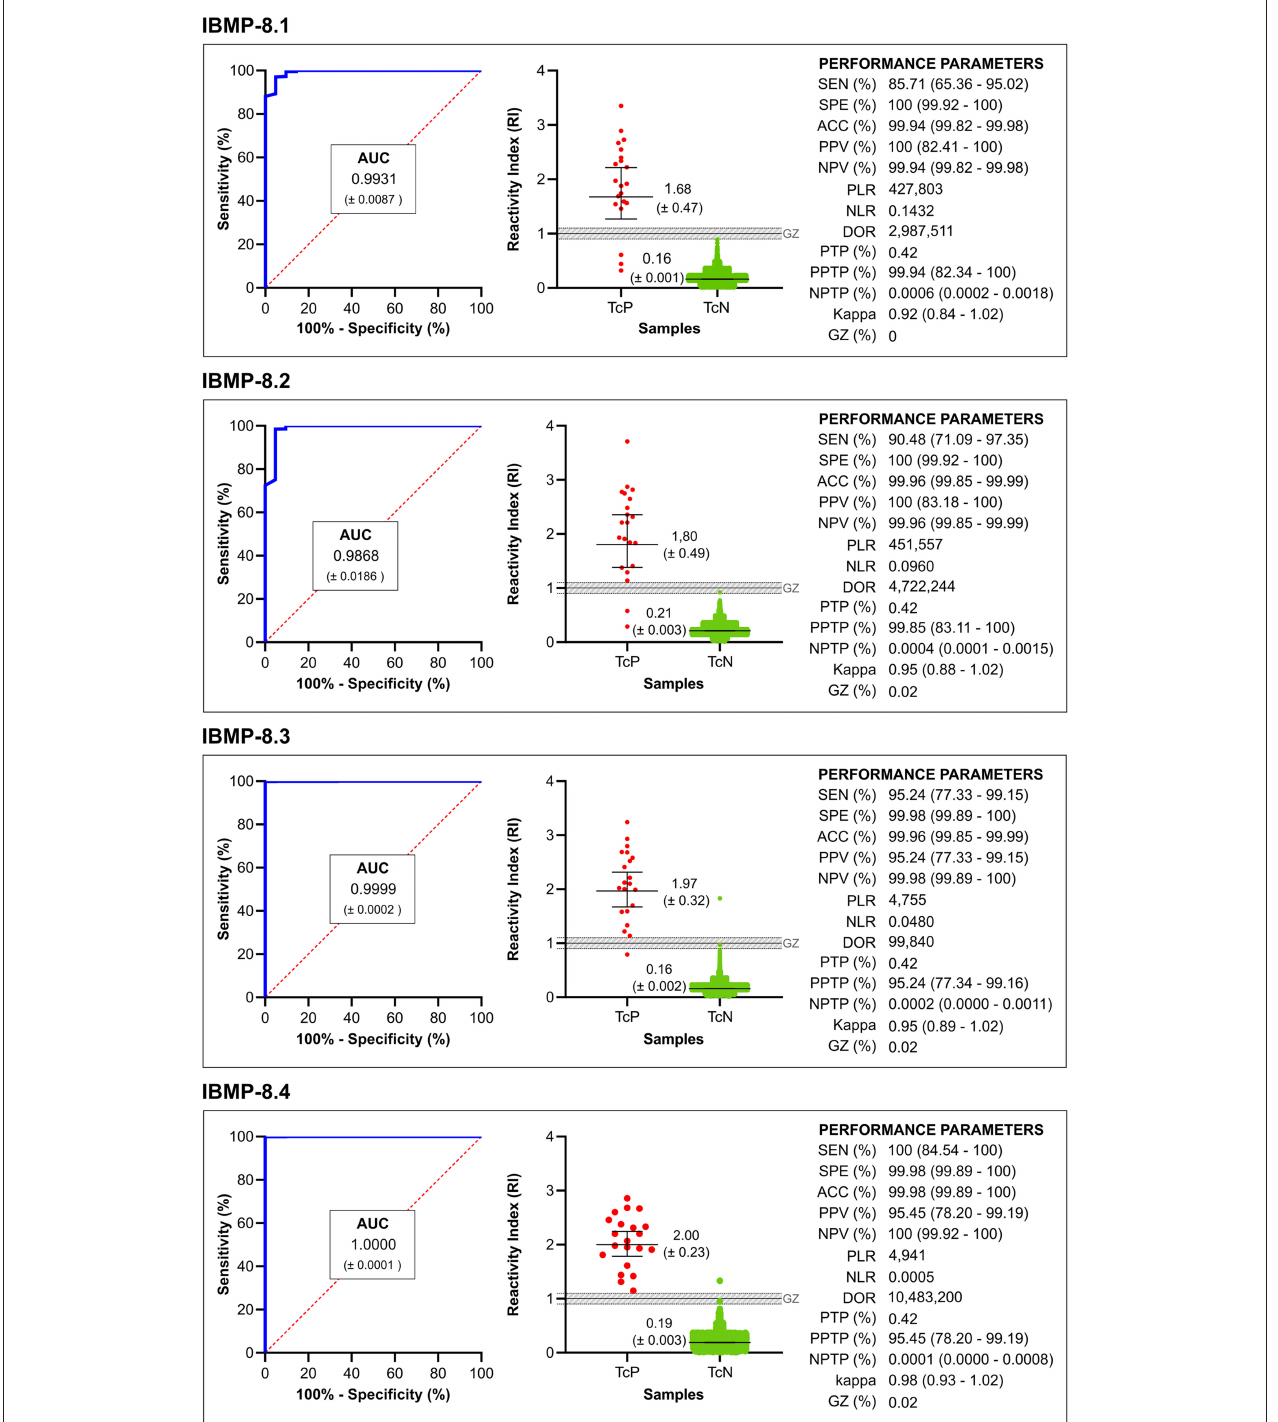
FIGURE 3 | Graphical analysis of areas under the curve (AUC) ROC (left). Reactivity index (middle) obtained with serum samples from Trypanosoma cruzi -positive (TcP) and Trypanosoma cruzi -negative (TcN) samples. The cut-off value is the reactivity index = 1.0 and the shaded area represents the gray zone (RI = 1.0 ± 0.10). The horizontal lines and numbers for each group of results represent the geometric means ( ± 95% CI). Performance parameters (right) obtained for all chimeric IBMP proteins. SEN, sensitivity; SPE, specificity; ACC, accuracy; PPV, positive predictive value; NPV, negative predictive value; PLR, positive likelihood ratio; NLR, negative likelihood ratio; DOR, diagnostic odds ratio; PTP, pre-test probability; PPTP, positive post-test probability; NPTP, negative post-test probability; Kappa, cohen’s Kappa coefficient; GR, gray zone.